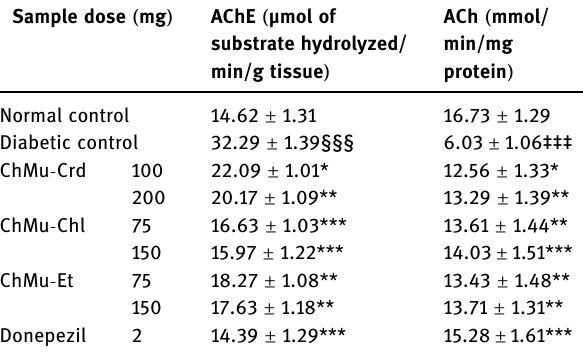
Table 8: E ff ect of ChMu - Crd and fractions on AChE activity and ACh level Sample dose ( mg